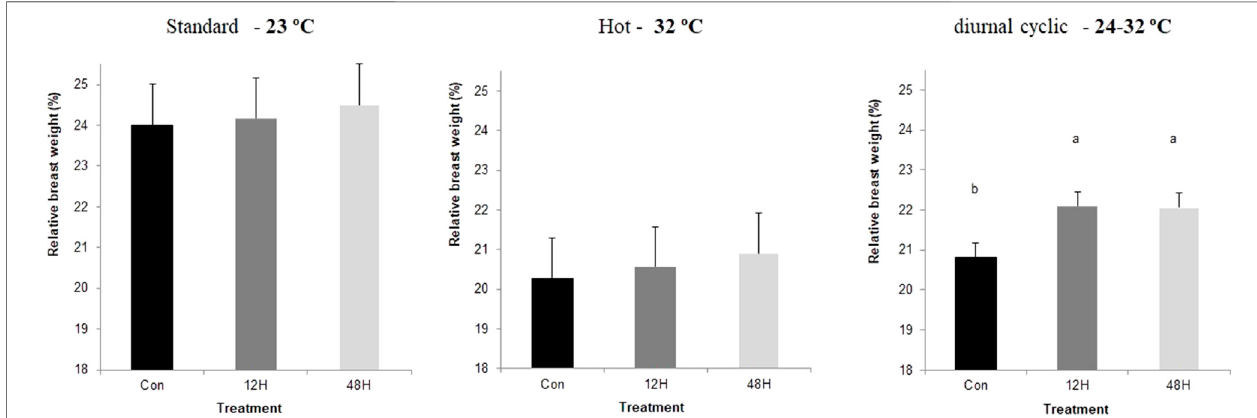
FIGURE 1 | Relative breast weight (% fi nal body weight at 42 day), of broilers that were exposed to different hypoxia regimes (12H and 48H) during embryonic development and then raised under different environmental ambient temperatures (cold, standard, hot, and diurnal cyclic ambient temperature).